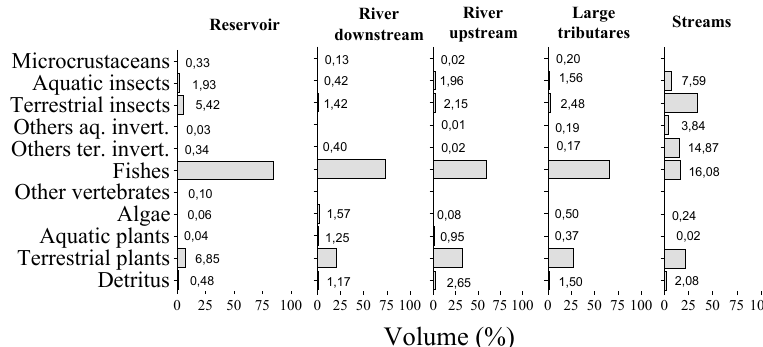
Fig. 2 . Food resource availability, inferred from the volume of food items in the stomachs analyzed for all species combined.